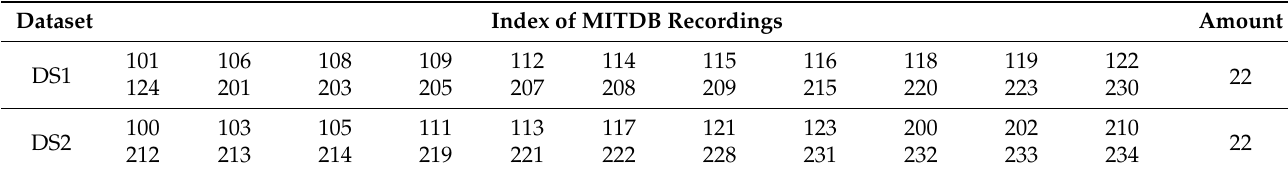
Table 1. Evaluation scheme of the MITDB.